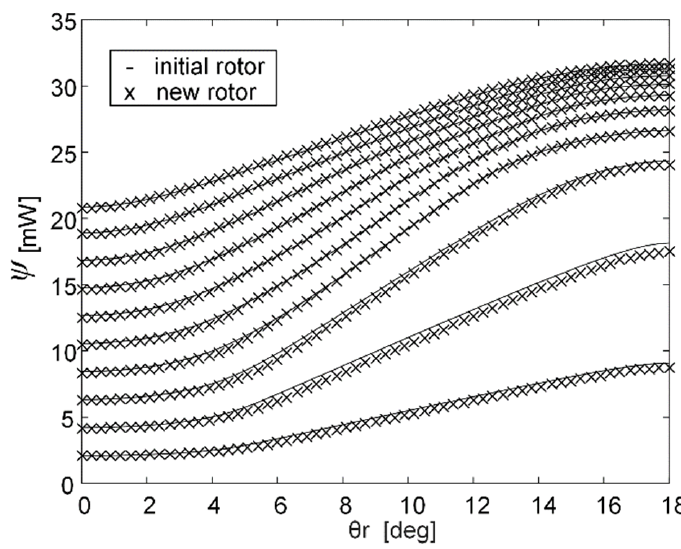
Figure 26. Static torque curves for initial and modified rotor designs.